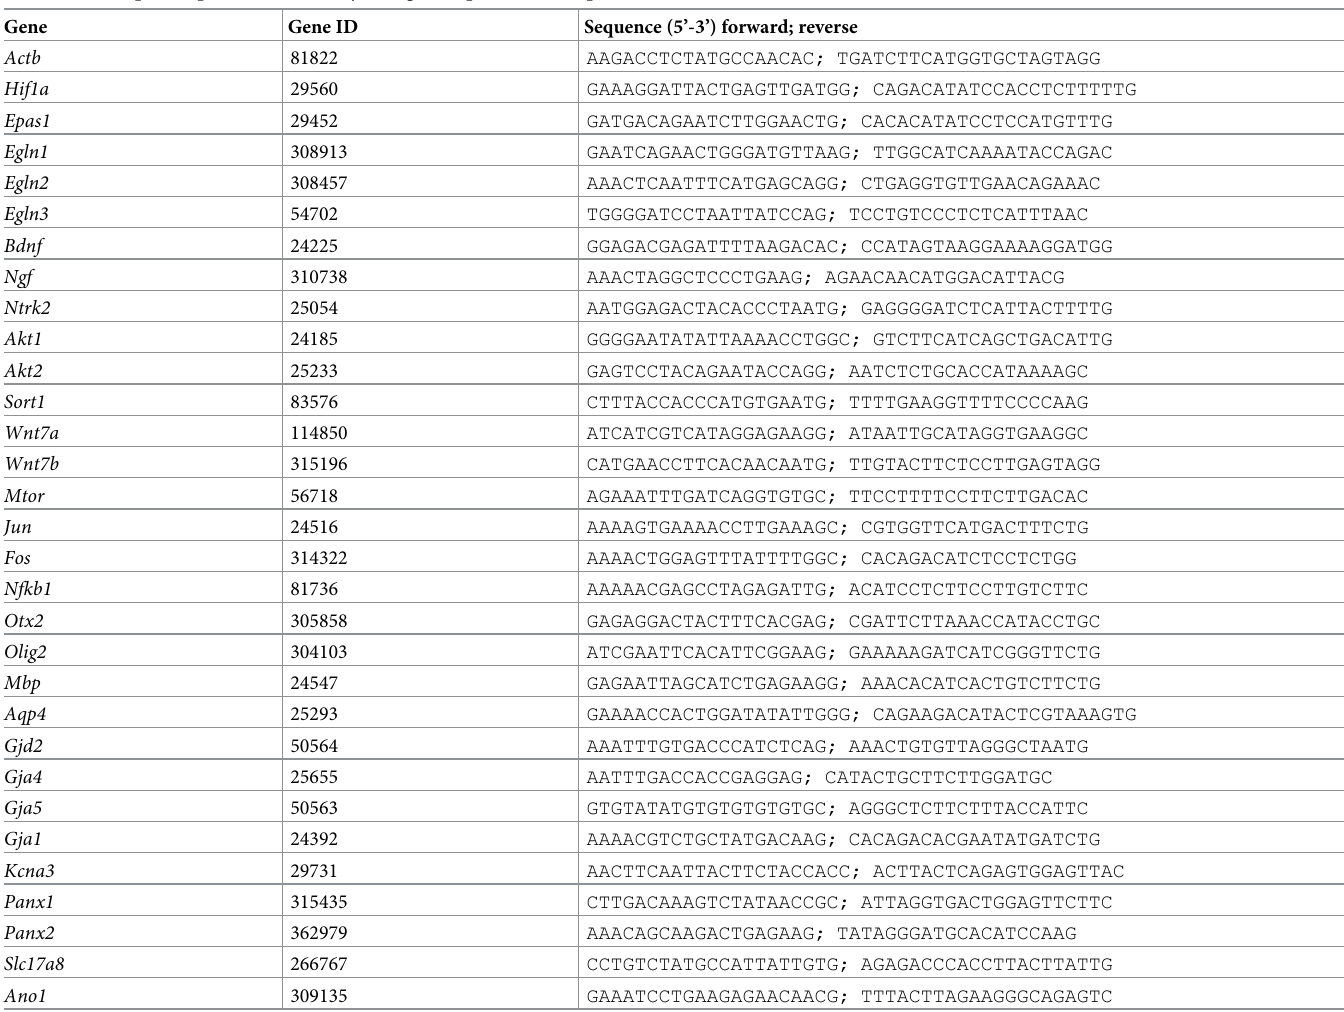
Table 3. List of primer pairs used for analysis of gene expression with